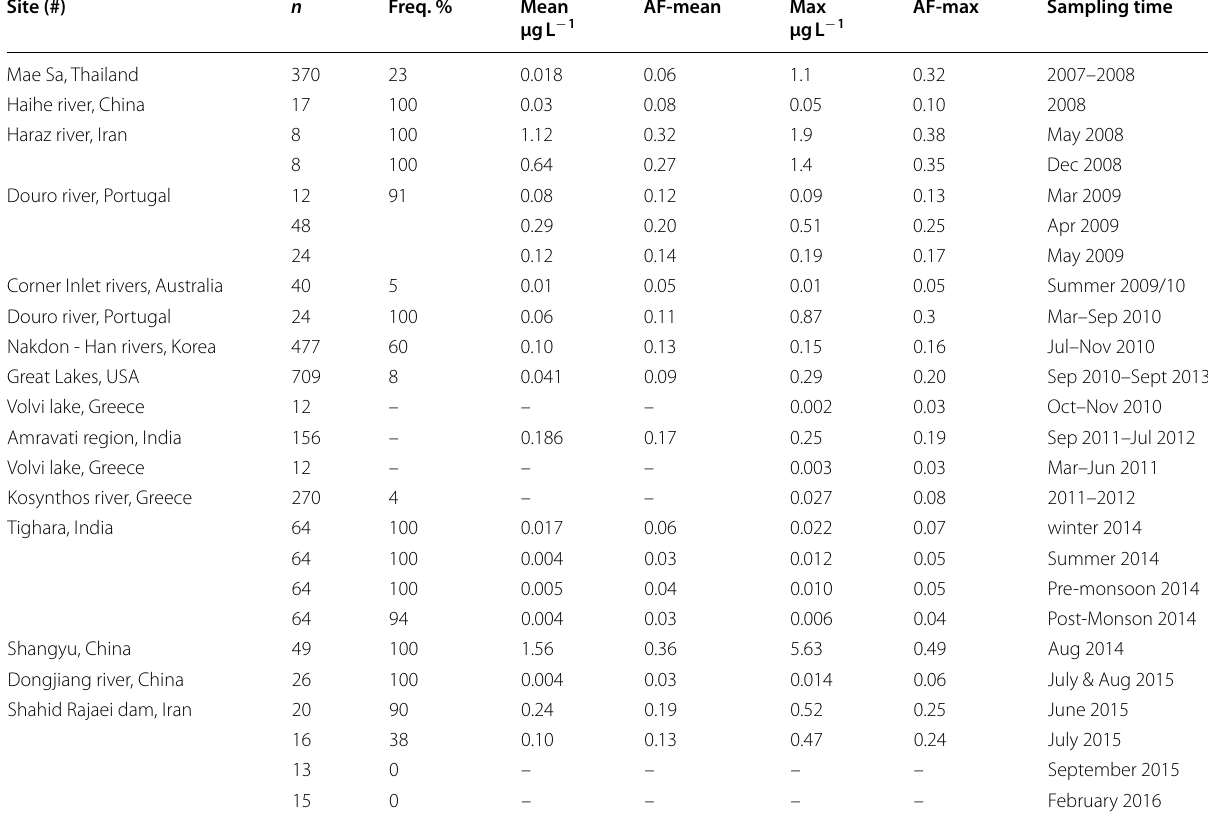
Table 3 Surface water sampling data for the last 15 years. References in Supplementary materials (Table S5) Site (#)